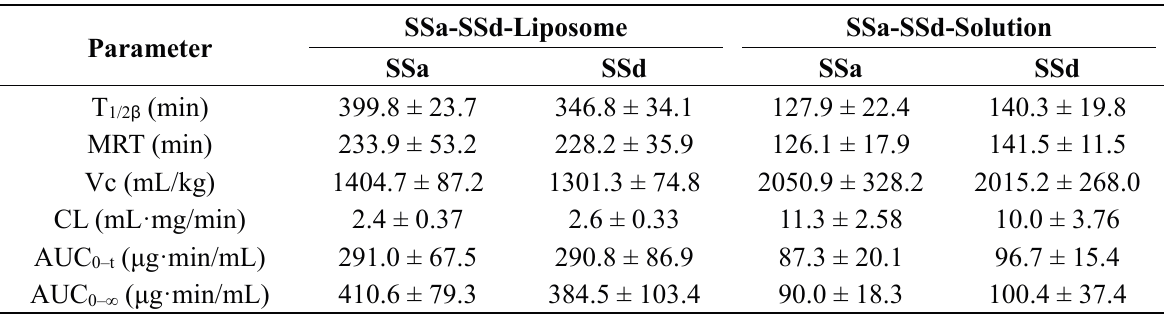
Table 12. Pharmacokinetic parameters of SSa and SSd in rats with intravenous administration of SSa-SSd-Lip and SSa-SSd-Sol (mean ± SD, n =